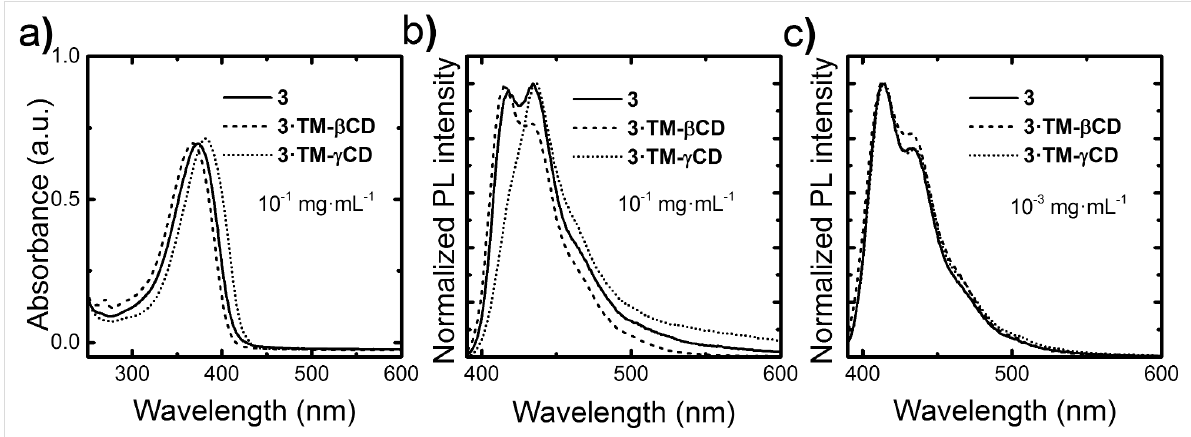
Figure 3: Optical properties of 3·TM- γ CD (dotted line), 3·TM- β CD (dashed line) and 3 (solid line) polymers: absorption spectra at 10 − 1 mg ∙ mL − 1 in CHCl 3 (a), and normalized emission spectra at 10 − 1 mg ∙ mL − 1 and 10 − 3 mg ∙ mL − 1 in CHCl 3 , (b) and (c), respectively.